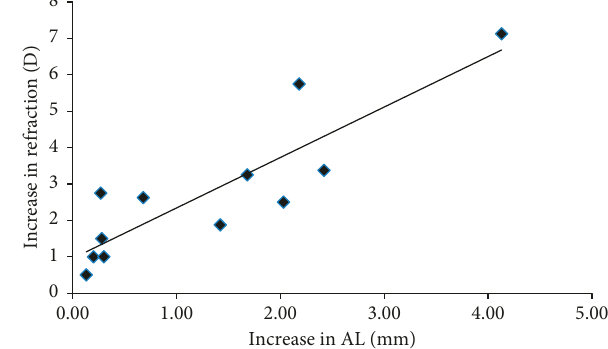
Figure 2: The relationship between myopia progression and change in axial length during the follow-up period in adults. AL: axial length; D: diopter.